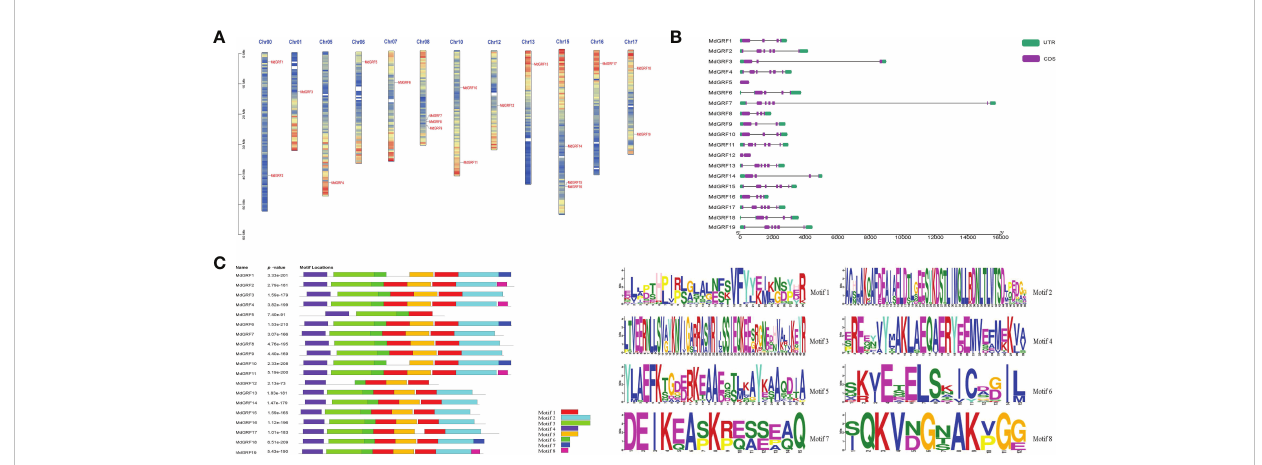
FIGURE 3 Characterization and chromosomal localization of the Md14-3-3 genes. (A) Chromosomal localization of 14-3-3 genes in apple. (B) Structural analysis of the Md14-3-3 genes. Different blocks represent UTRs (green), CDs (purple), and introns (black lines). (C) The motif details of the identi fi ed conserved domains of the Md14-3-3 proteins. Each motif is represented by a different colored